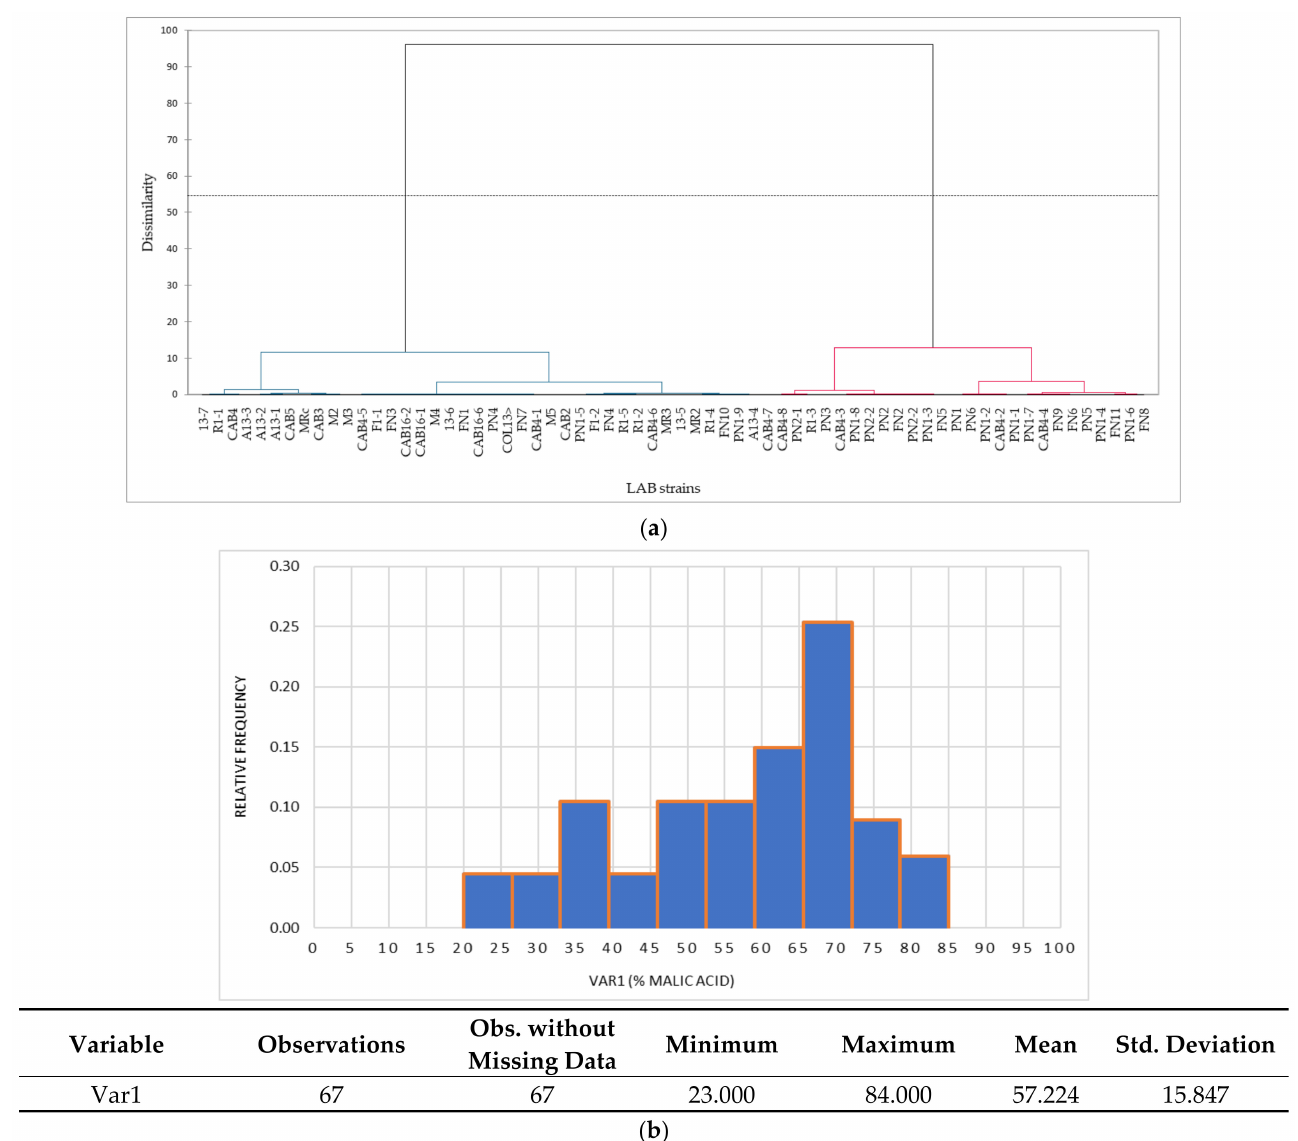
Figure 4. Dendrogram of isolated bacterial strains based on their ability to metabolize malic acid ( a ) and histogram of LAB group distribution (relative frequency) according to their malic acid bioconversion capacity ( b